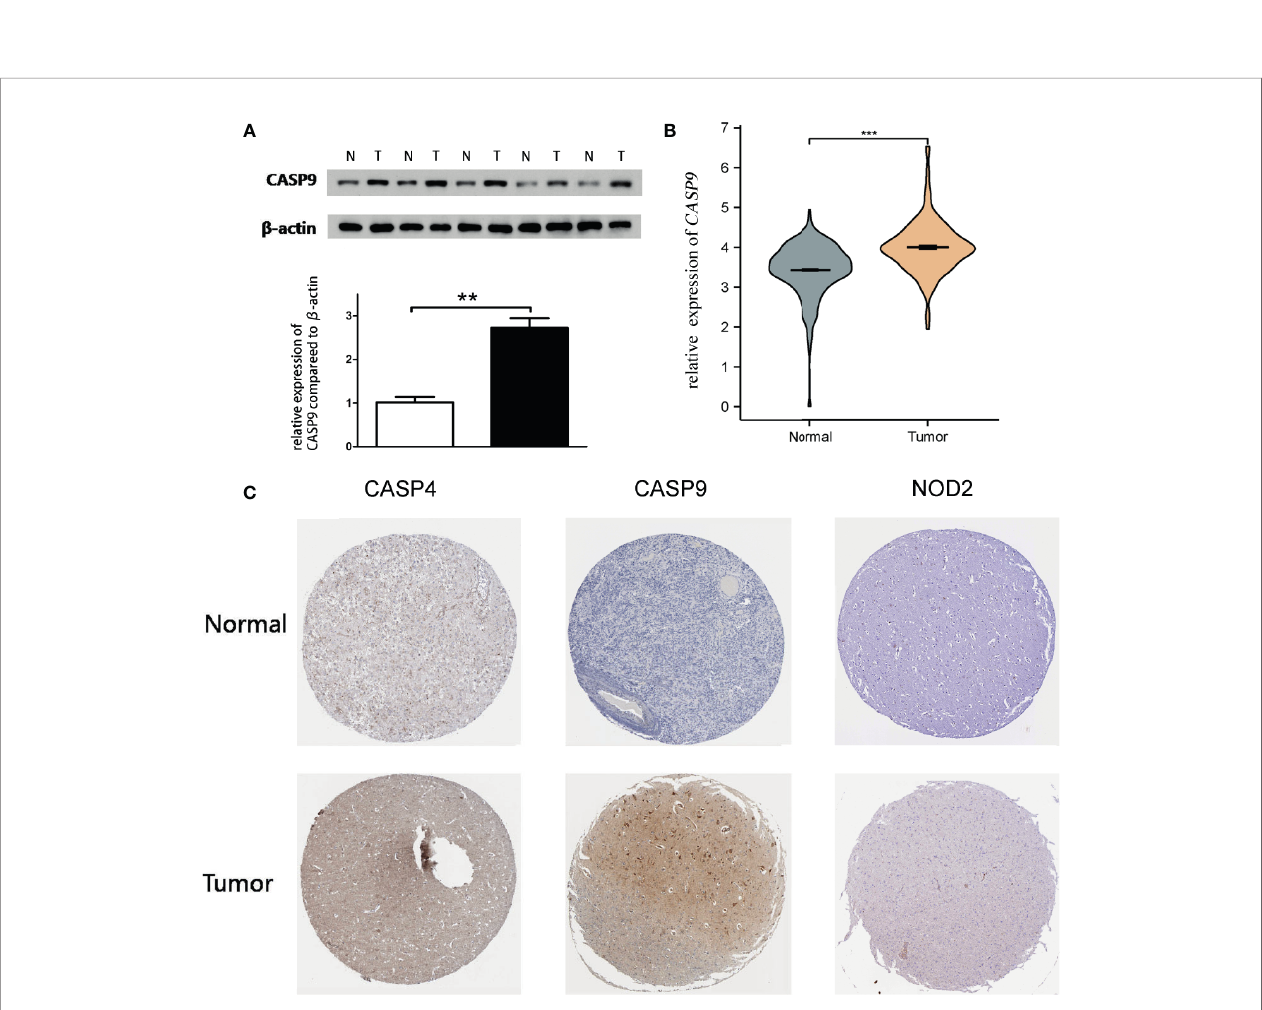
FIGURE 4 | Quantitative real-time PCR (qRT-PCR) and Western blotting. (A) Western blot analysis showed a clear overexpression in protein expression levels of CASP9 in GBM. (B) Results of qRT-PCR analysis. (C) The level of three pyroptosis-related DEGs ( CASP4 , CASP9 , and NOD2 ) protein in GBM tissue was upregulated compared with normal tissue. **P < 0.01; ***P <